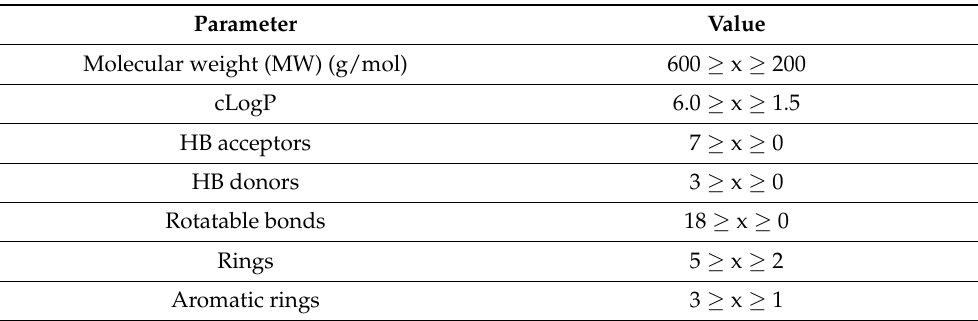
Table 6. Summary of the parameter restrictions applied during physicochemical descriptor filtering prior to virtual hit